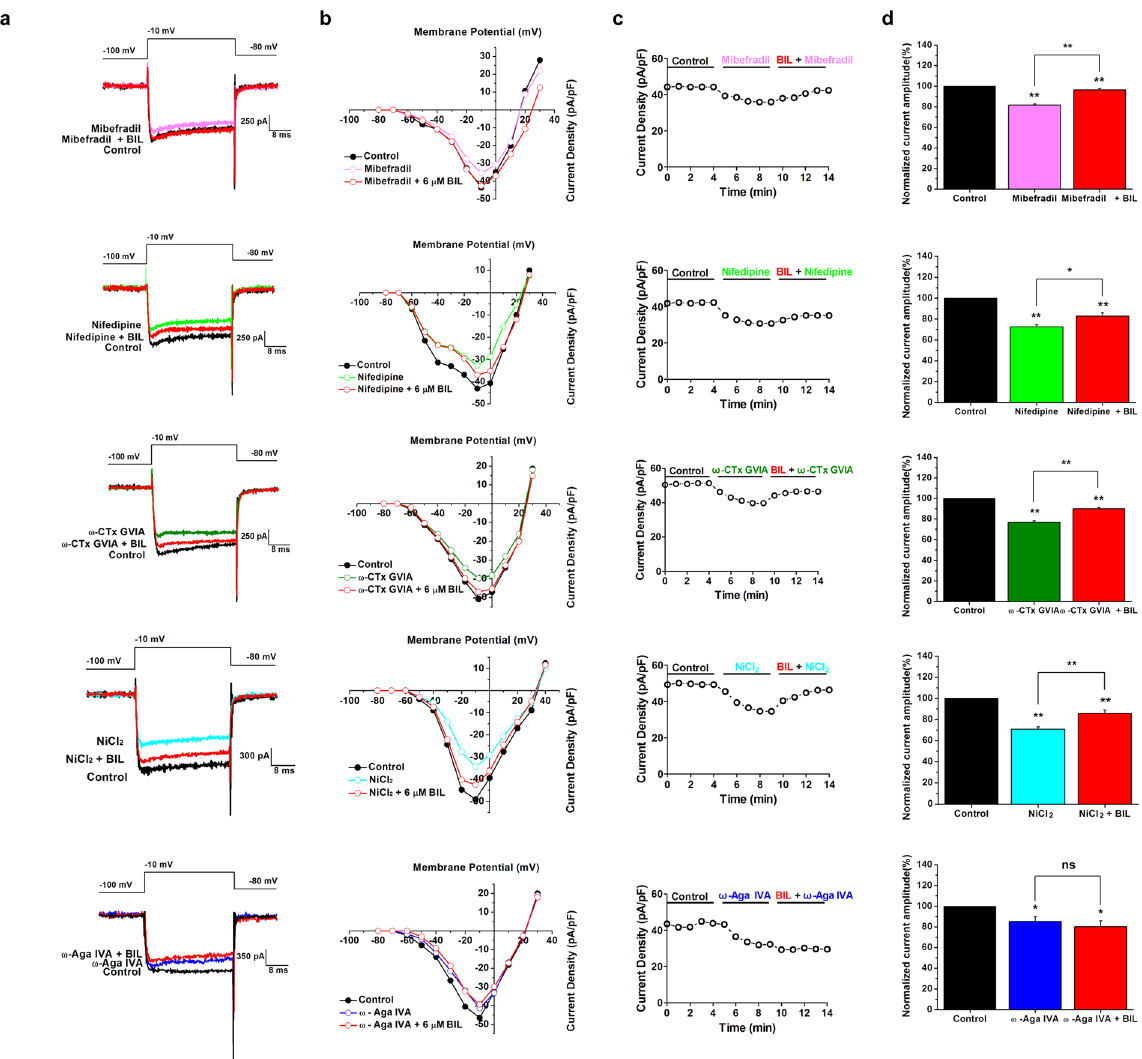
Figure 4. Pharmacological isolation of the VGCC current component enhanced by bilirubin. ( a ) Example traces are shown in control (black traces), during application of 1 µ M Mibefradil (top panel, magenta trace, n = 7), 10 µ M Nifedipine (2nd panel, green trace, n = 7), 1 µ M ω -CTx GVIA (3rd panel, olive trace, n = 7), 50 µ M NiCl 2 (4th panel, cyan trace, n = 7), or 500 nM ω - Agatoxin IVA (bottom panel, blue trace, n = 7), respectively, and subsequent application of 6 µ M Bilirubin (red traces), elicited by step depolarizations to − 10 mV from a hyperpolarizing potential of − 100 mV. ( b ) Current-voltage relationships from data in A measured at the peak current density showed calcium currents in control (black traces), Mibefradil (top panel, magenta trace), Nifedipine (2nd panel, green trace), ω -CTx GVIA (3rd panel, olive trace), NiCl 2 (4th panel, cyan trace), or ω - Agatoxin IVA (bottom panel, blue trace), respectively, and further addition of 6 µ M bilirubin (red traces). ( c ) Time course of the effect of control condition, each antagonist and co-application of bilirubin. The calcium current density is plotted against time. ( d ) The normalized VGCC current amplitude before (black bars), during application of Mibefradil (top panel, magenta bar), Nifedipine (2nd panel, green bar), ω -CTx GVIA (3rd panel, olive bar), NiCl 2 (4th panel, cyan bar), or ω - Agatoxin IVA (bottom panel, blue bar), respectively, and combined application of 6 μ M bilirubin (red bars). Charge carrier: 5 mM Ba 2 + . * P < 0.05, ** P < 0.01, ns, not significant, one-way ANOVA with Bonferroni post hoc